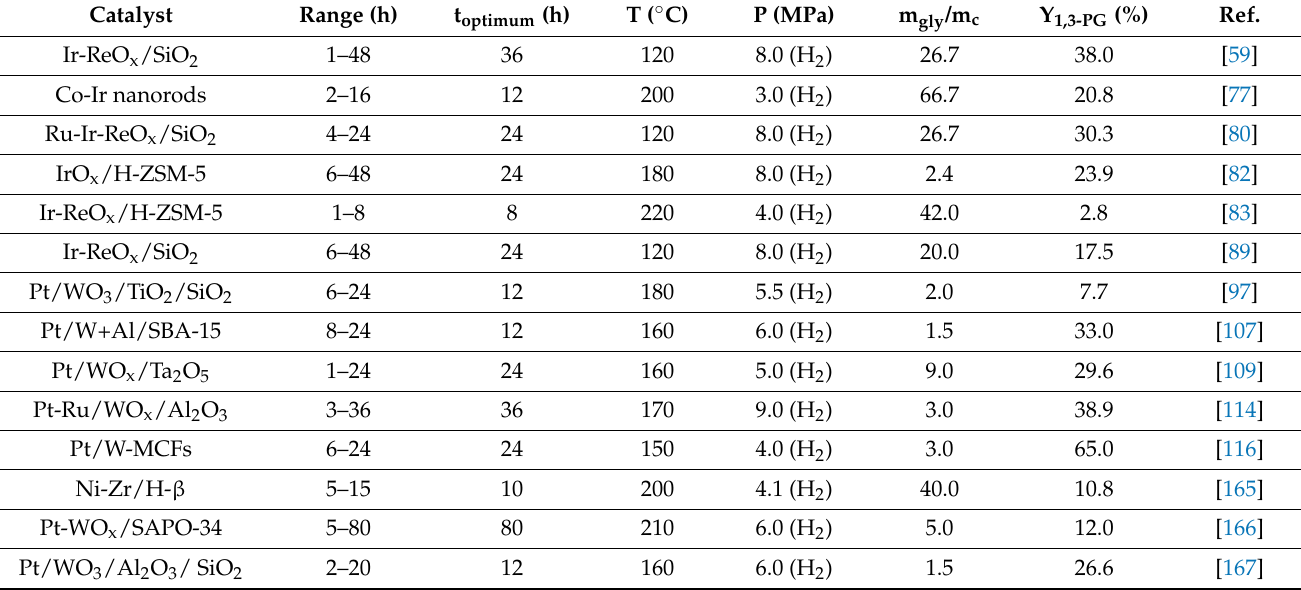
Table 14. The effect of reaction time in the liquid phase using batch reactors.